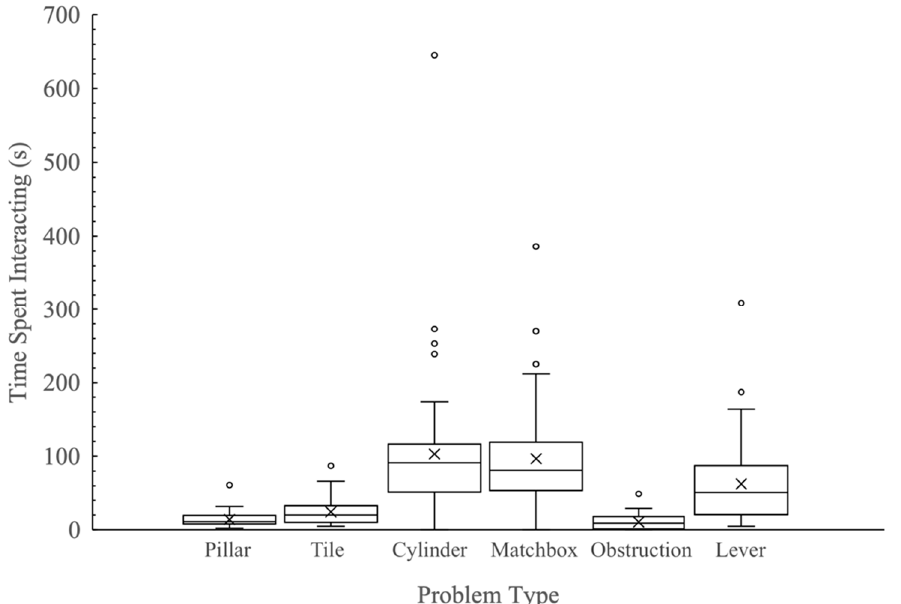
Figure 2. Boxplot graphs of the relationship between problem type and time spent interacting (s) with the tasks of fawn-footed mosaic-tailed rats ( Melomys cervinipes ). The mean for each group is indicated by X.